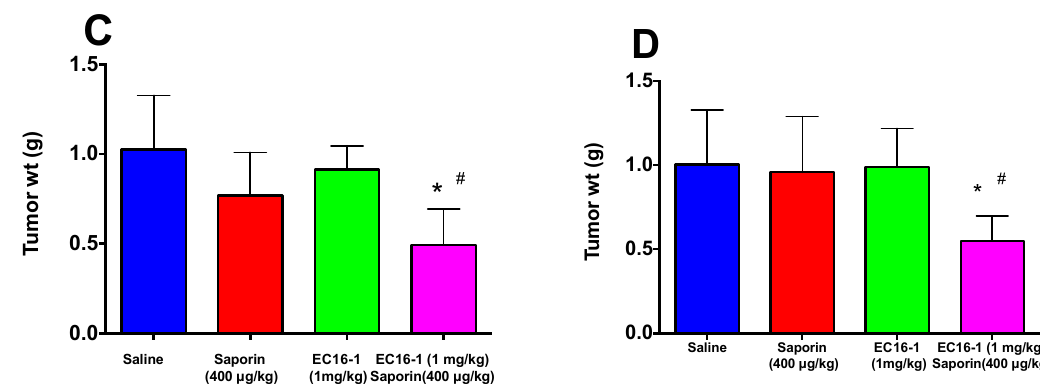
Figure 6. Effect of EC16-1/saporin on the volume and weight of SW620 and SW620/AD300 tumors. The changes in tumor volume over time in SW620 ( A ) and SW620/AD300 ( B ) in xenografts following implantation. Each point on the line graph represents the mean tumor volume (mm 3 ) on each day after implantation. The error bars represent the SD. The mean weight ( n = 6) of the excised SW620 ( C ) and SW620/AD300 ( D ) tumors from the mice treated with saline, saporin, EC16-1, and EC16-1/saporin, at the end of the 12-day treatment period. The error bars represent the SD. * p < 0.05, compared with the saporin alone group. # p < 0.05, compared with the control group.